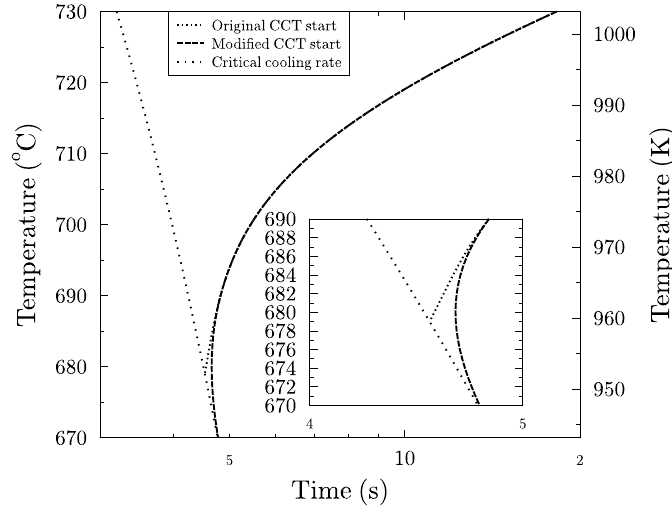
Figure 1. The continuous cooling transformation (CCT) diagram for the given steel composition can be calculated with the parameters reported in [21]. To describe the CCT “nose” without discontinuities in the derivative, a spline was fitted between the calculated CCT curve and the critical cooling